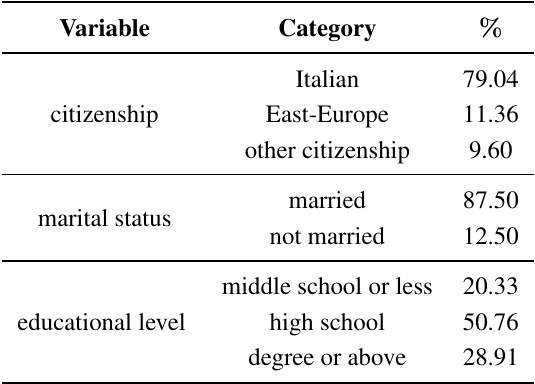
Table 3. Distribution of control